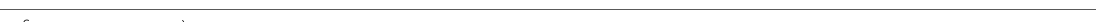
figure on next Fig. 2 miR-182-5p stimulates proliferation, migration and angiogenesis of HUVECs. A miR-182-5p expression and MVD in metastasis tissues from 16 breast cancer patients with distant metastasis detected by ISH and immunohistochemical staining, the statistical power was 1; B Pearson correlation analysis of the relationship between miR-182-5p and MVD, the statistical power was 0.572; C miR-182-5p expression in HUVECs detected by RT-qPCR, the statistical power was 1; D VEGF protein expression in HUVECs detected by Western blot analysis, the statistical power was 1; E Proliferation of HUVECs detected by CCK-8 method, the statistical power was 1; F HUVECs migration ability detected by Scratch test, the statistical power was 1; G HUVECs migration ability detected by Transwell assay, the statistical power was 1; H Vessel-like tube formation in HUVECs, the statistical power was 1. * p < 0.05, *** p < 0.001, **** p < 0.0001 compared with cells treated with mimic NC or breast cancer patients without distant metastasis; # p < 0.05, ## p < 0.01, ### p < 0.001, #### p < 0.0001 compared with cells treated with inhibitor NC. The experiment was conducted three